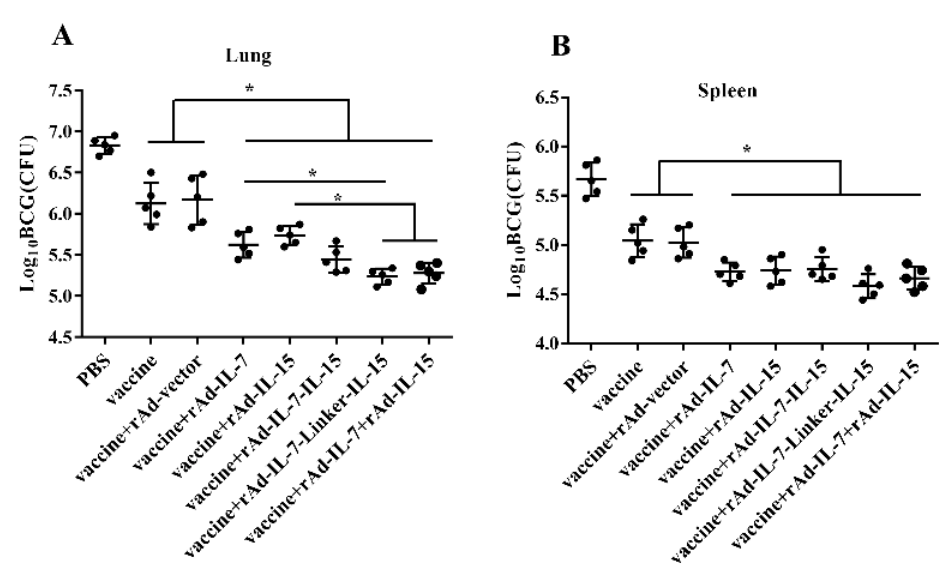
Figure 5. The protective efficacy of vaccines against BCG infection in mice. At 24 weeks after the last vaccination, mice were challenged with Mycobacterium bovis BCG 1 × 10 7 CFU / 100 µ L / mice by nasal. 3 weeks post-challenge, ( A ) mice were euthanized and the bacterial burden (CFU) was measured in lungs; ( B ) mice were euthanized and the bacterial burden (CFU) was measured in spleens. Data are presented as log10 CFU ± SD from groups of 5 mice. * p < 0.05.